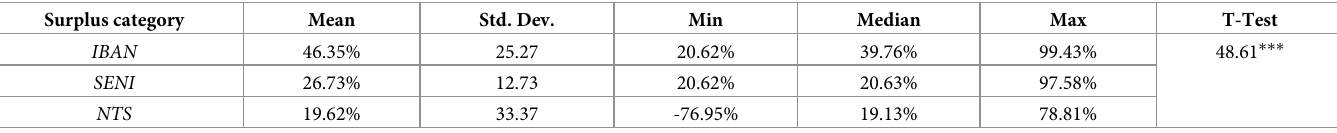
Table 6. Estimation of the occupied surplus effect and descriptive statistics. Surplus